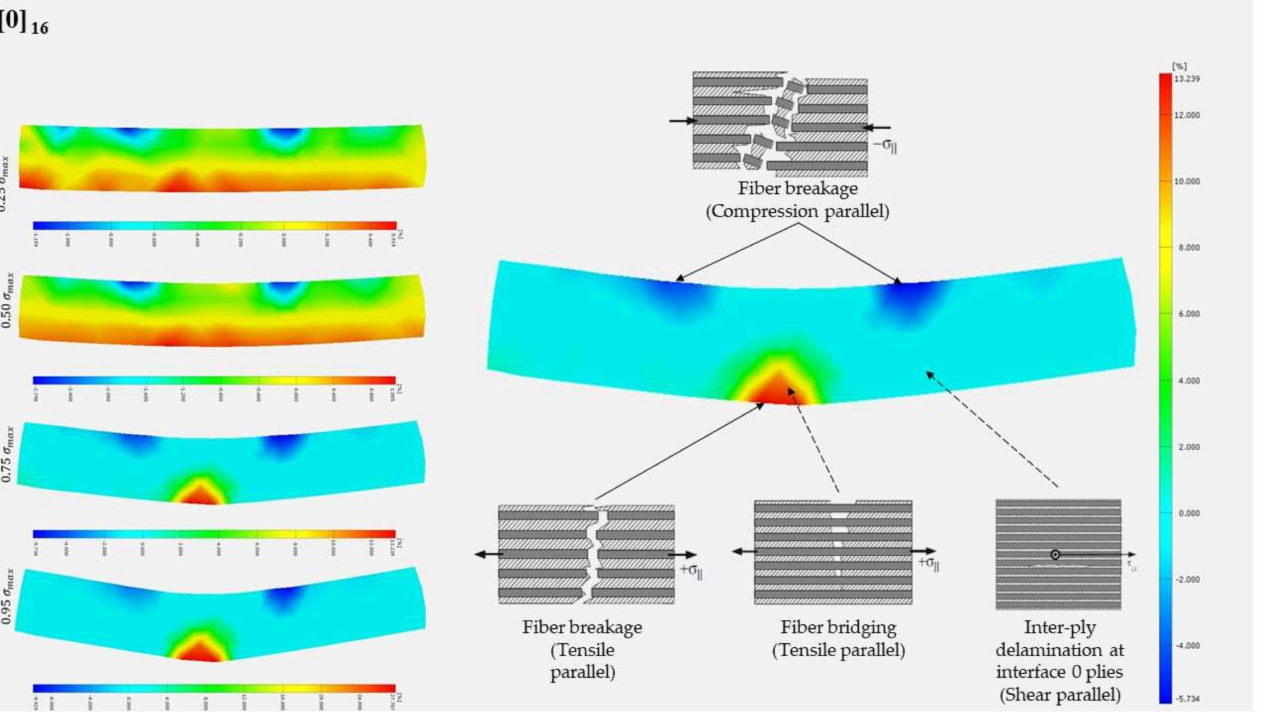
Figure 2. ε xx strain measured by DIC at various load levels for [0] 16